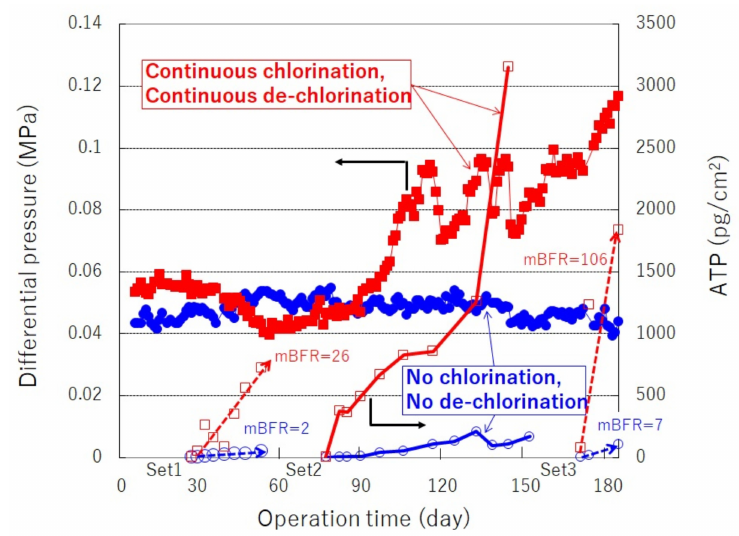
Figure 21. Chlorine sterilization and SBS dosing triggers biofouling